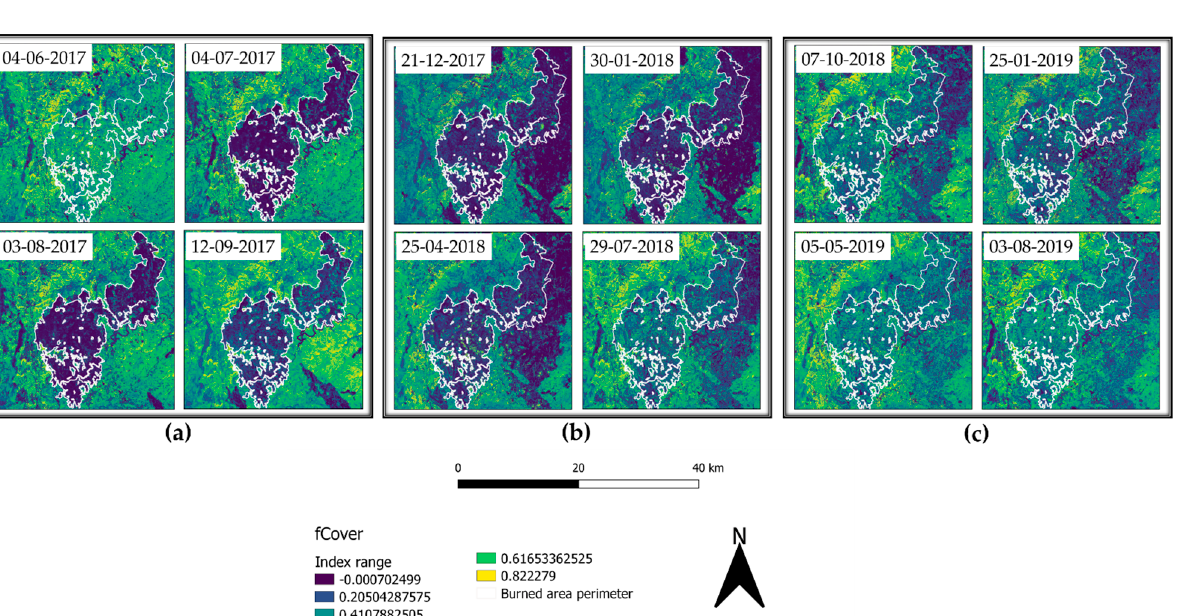
Figure 10. fAPAR index timeseries computed for: ( a ) the burned area (medium severity); ( b ) unburned area.